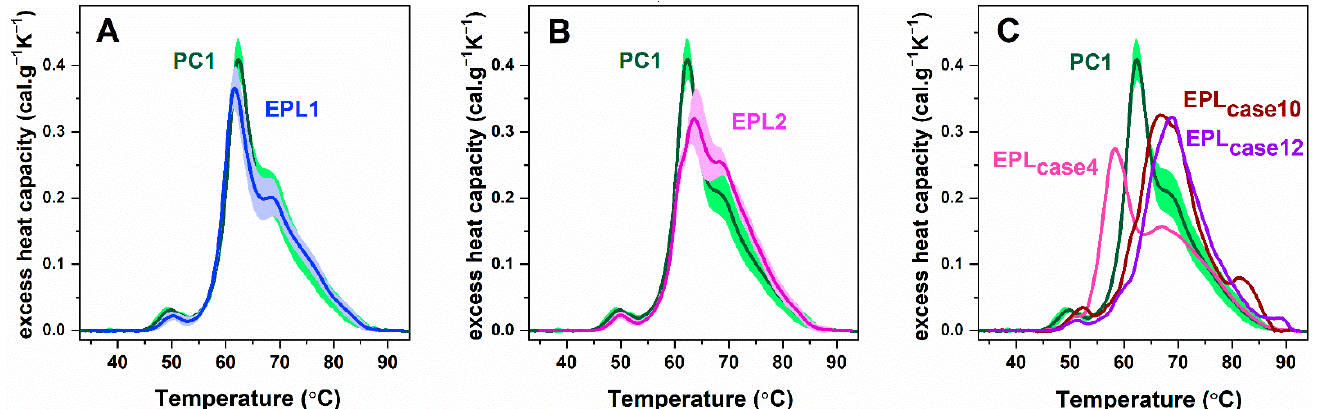
Figure 2. Calorimetric profiles (mean ± SD) of blood plasma derived from women with early pregnancy loss (EPL). Panel ( A ): EPL1 group (blue line, blue shadow); panel ( B ): EPL2 group (magenta line, light violet shadow); panel ( C ): ungrouped thermograms of cases 4 (pink line), 10 (wine line), and 12 (violet line). For clarity, the average blood plasma profile registered for healthy pregnant women (PC1, dark green line, and green shadow) is presented in each panel. All thermograms are recorded with a scan rate of 1 °C min − 1 in the range of 30–95 °C. Table 3. Thermodynamic parameters: denaturation temperatures (T m ) and excess heat capacities (c P ) of the main thermal transitions; the c P ratio of albumin and globulins assigned transitions, c PHSA /c PIgs ; calorimetric enthalpy ( ∆ H); weighted average center of the thermograms (T FM ), and similarity parameters (r, P, (cid:36) according to Fish et al. 2010), estimated from the DSC profiles of blood plasma for pregnant women in the first trimester of pregnancy (PC1) and for patients with early pregnancy loss (EPL). The data are presented as mean values ± SD.